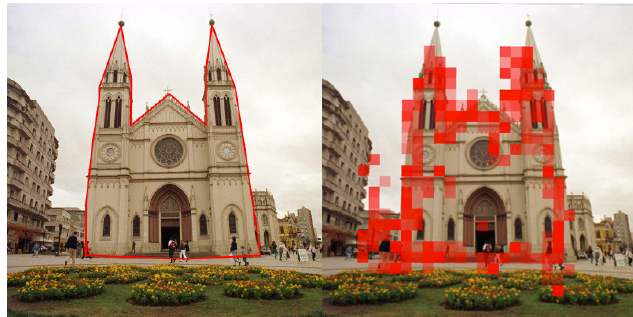
Figure 11. The left side image is a representation of 2D path requested to the user to follow while using the application. The right side image shows the points obtained by the collector and rendered in the data analysis tool.